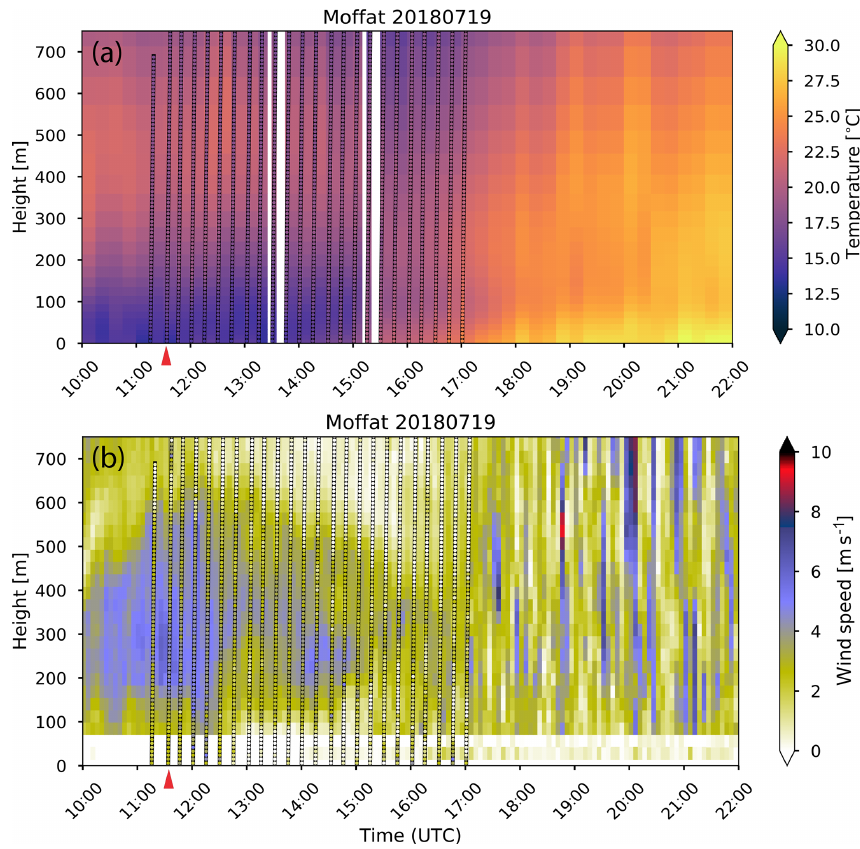
Figure 11. Time–height plots of temperature (a) and wind speed (b) from the Moffat site on 19 July 2018. The background is temperature from the AERI retrievals, while the points overlaid on top are data from the CopterSonde at approximately 9m resolution. The red arrow points to the profile shown in Fig.